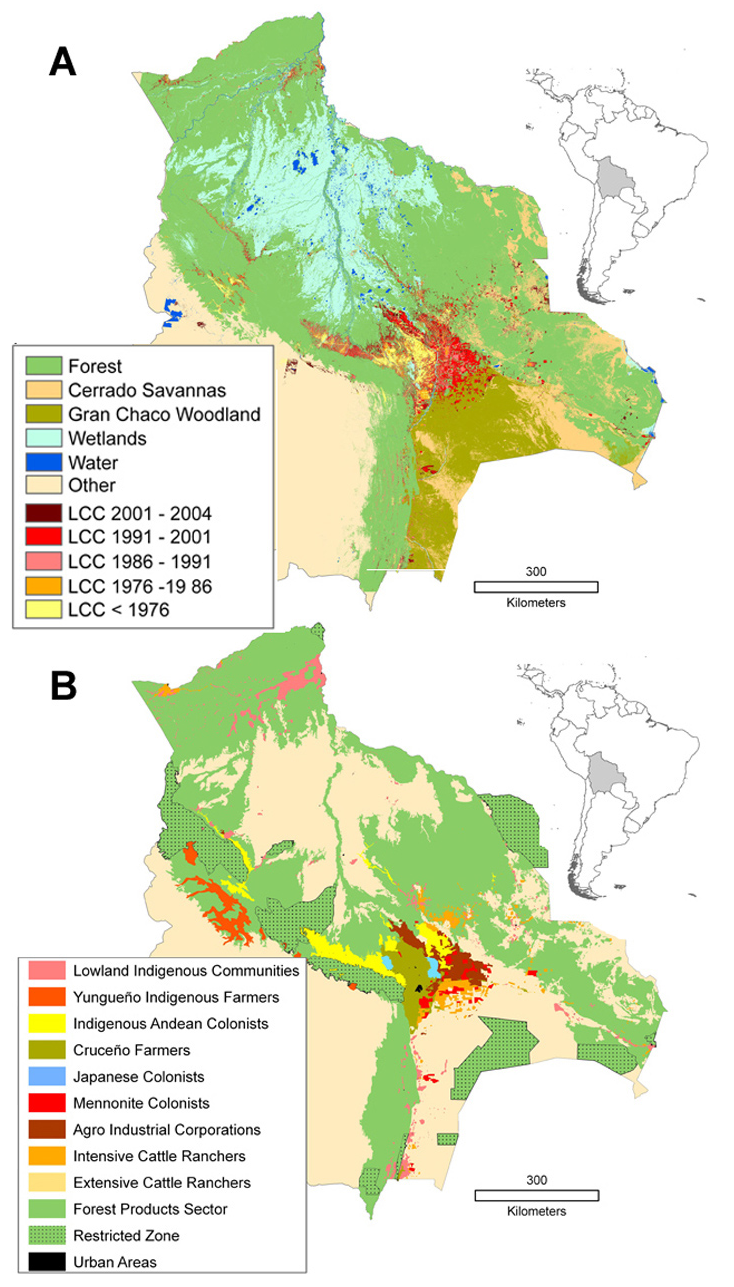
Fig. 1. (A) Land cover and historical land-cover change (LCC) in eastern Bolivia below the cloud forest treeline (~3000 m), modified from Killeen et al. (2007). For LCC, the colored areas represents the outside edge of the deforestation front for agriculturalists in the most recent temporal period; the absence of LCC indicates the forest products sector and extensive cattle ranchers groups. (B) Geographic footprint of the major economic and social